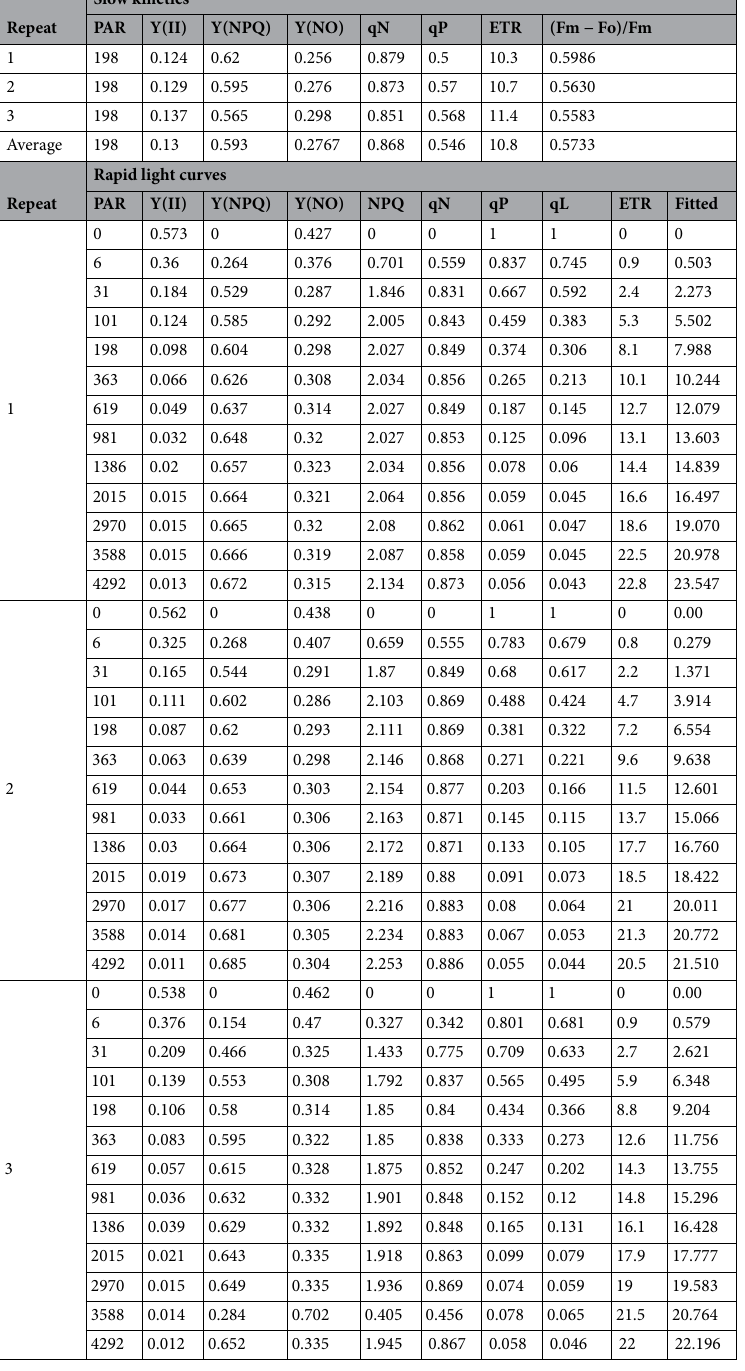
Table 5. Slow kinetics and rapid light curves of chlorophyll fluorescence in Epimedium pubescens leaves. Unit of PAR: µmol m −2 s −1 . Unit of ETR: μmol m −2 s −1